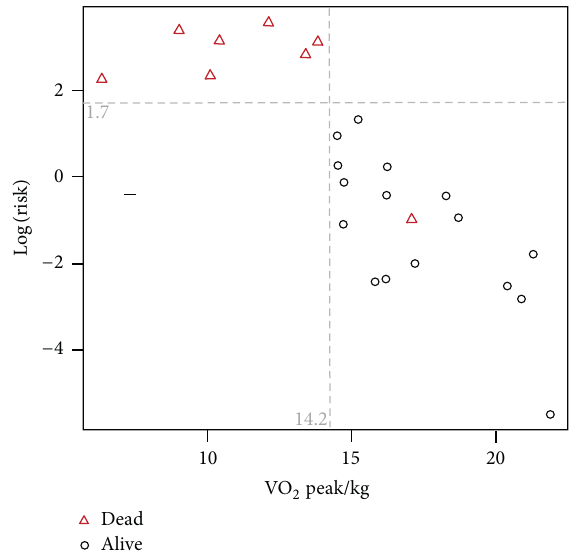
Figure 3: A threshold of mortality was identified. A threshold VO 2 peak/kg of 14.2mL/min/kg was associated with an increased risk of mortality according to optimum Cox proportional hazards